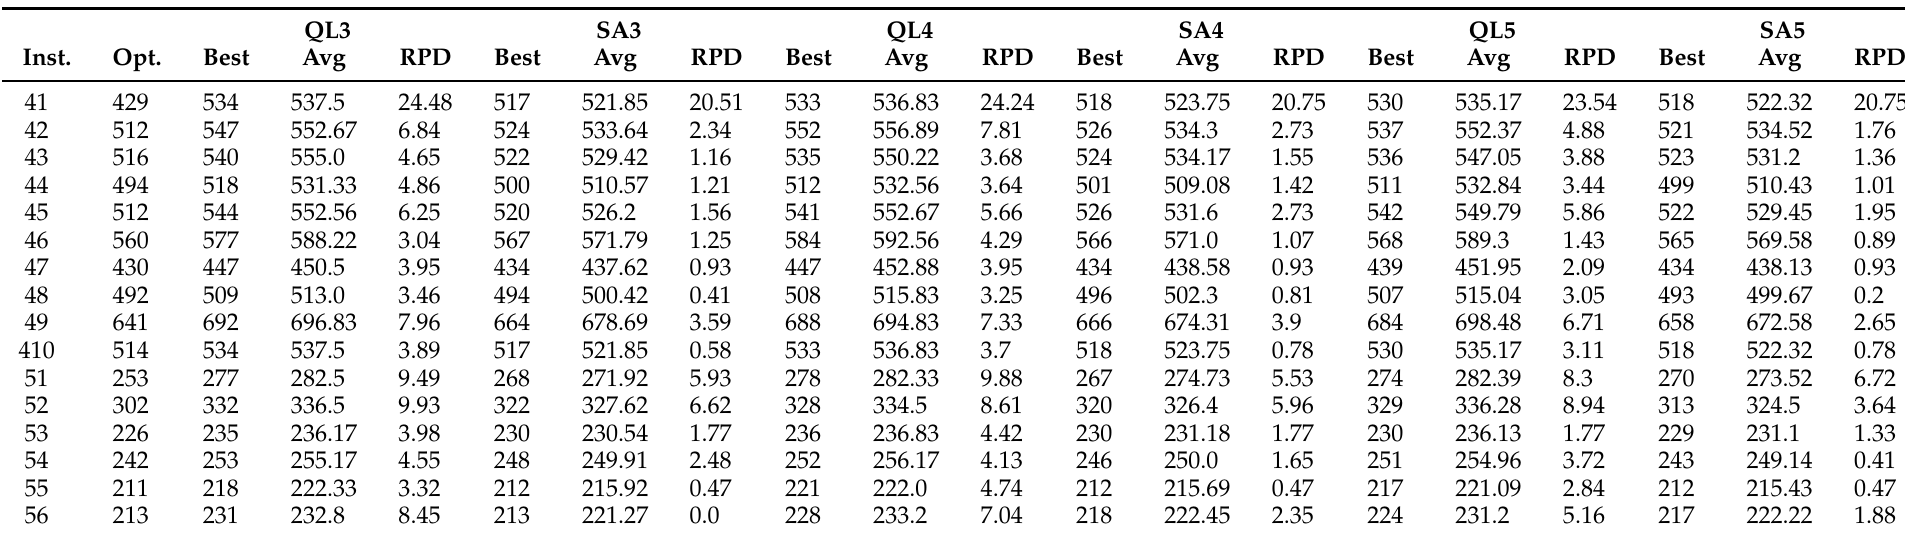
Table 10. Result comparison with SCA employing the approaches QL3, SA3, QL4, SA4, QL5, and